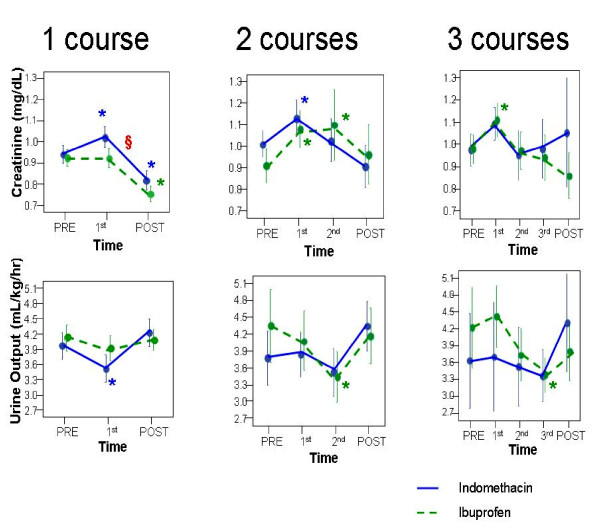
Mean urine output and creatinine values by drug and number of courses. Comparison of mean urine output and creatinine values by treatment drug for subgroups and defined by the total number of courses received. Left panel: patients who received only one course of either ibuprofen or indomethacin. Middle panel: patients who received total of two courses. Right panel: patients who received 3 total courses of medical treatment. Indomethacin group (solid line) and Ibuprofen group (dashed line). PRE - pre-treatment baseline; 1st - end of first course of treatment, POST - 3-5 days after the last course of treatment. * denotes statistically significant (p < 0.05) change from baseline within a treatment group. § denotes statistically significant (p < 0.05) difference in change from baseline between treatment groups.